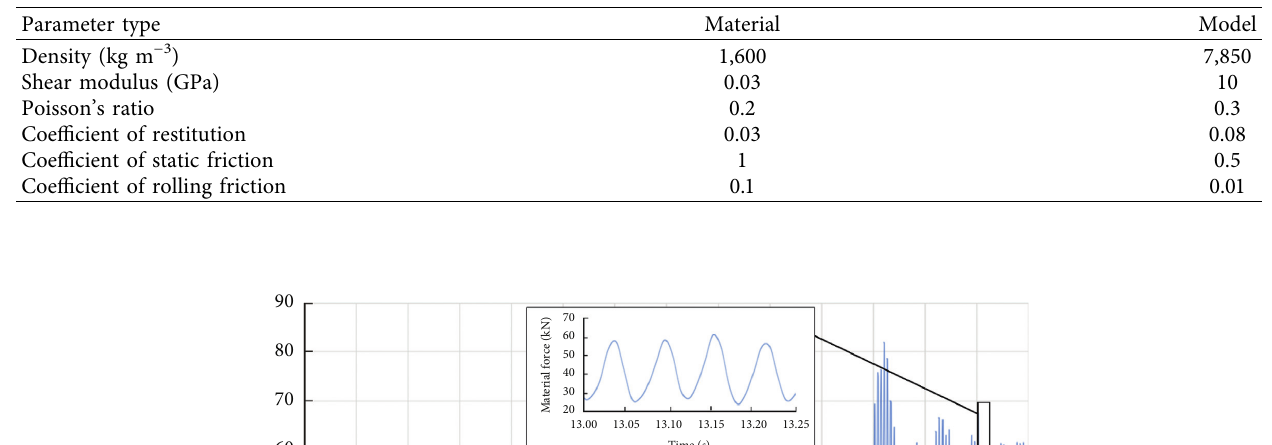
Figure 1: EDEM simulation of vibrating feeding system. Table 1: Parameters set in